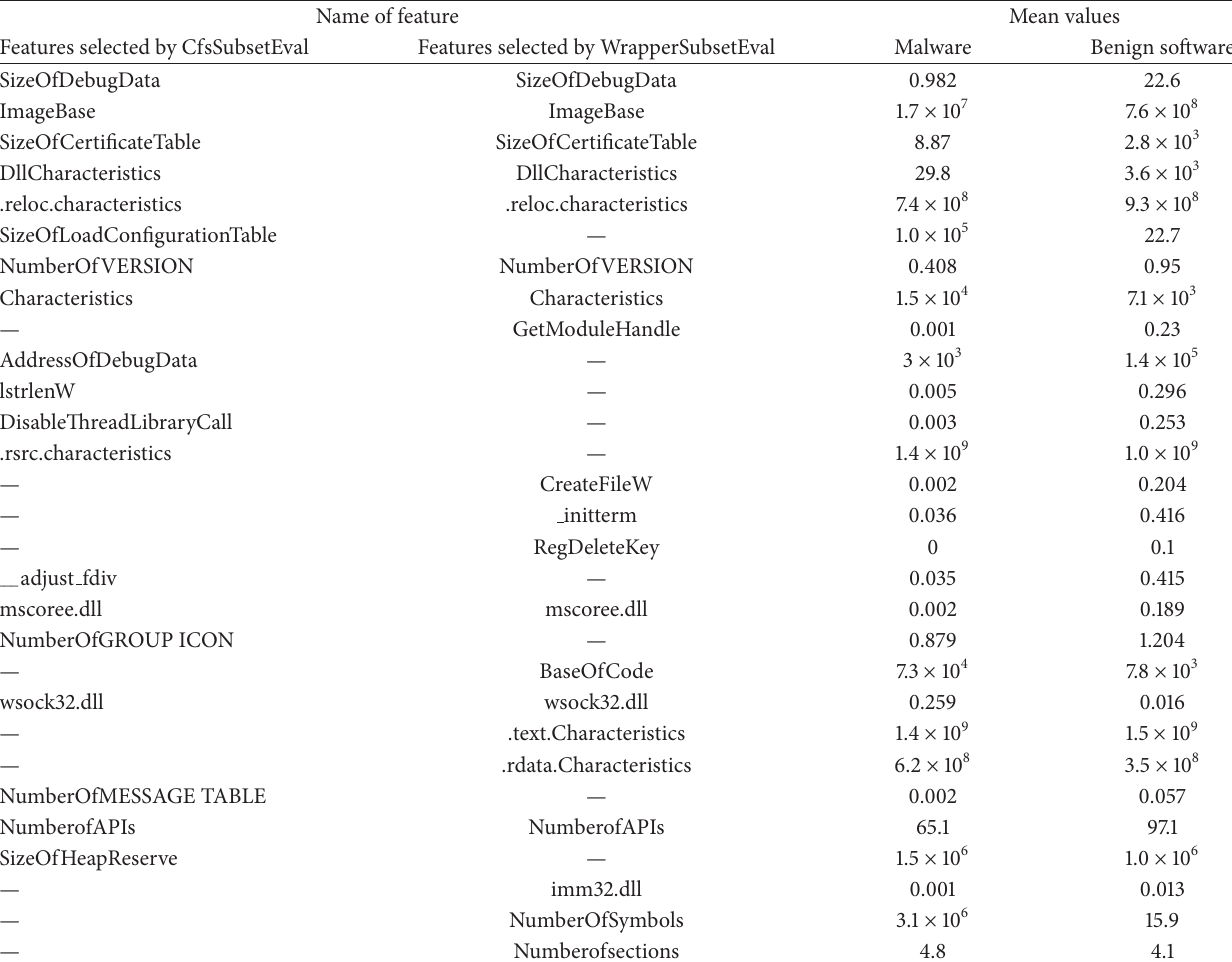
Table 4: The mean values of selected